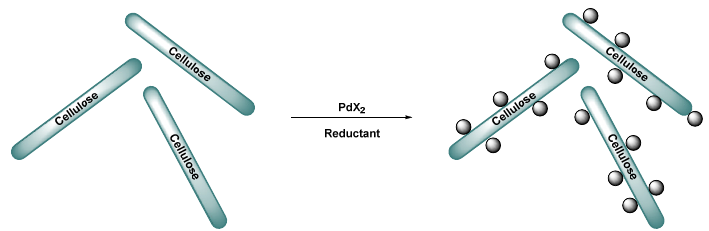
Figure 11. Reduction of Pd(II) onto cellulose as Pd NPs [84].